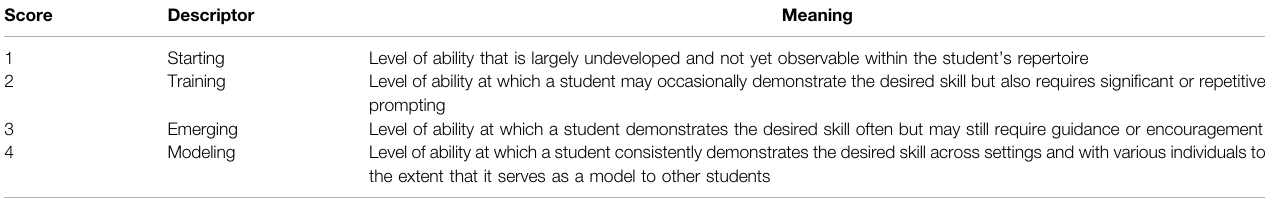
TABLE 2 | Project based rubric for 21st century skills: score descriptors. Score Descriptor